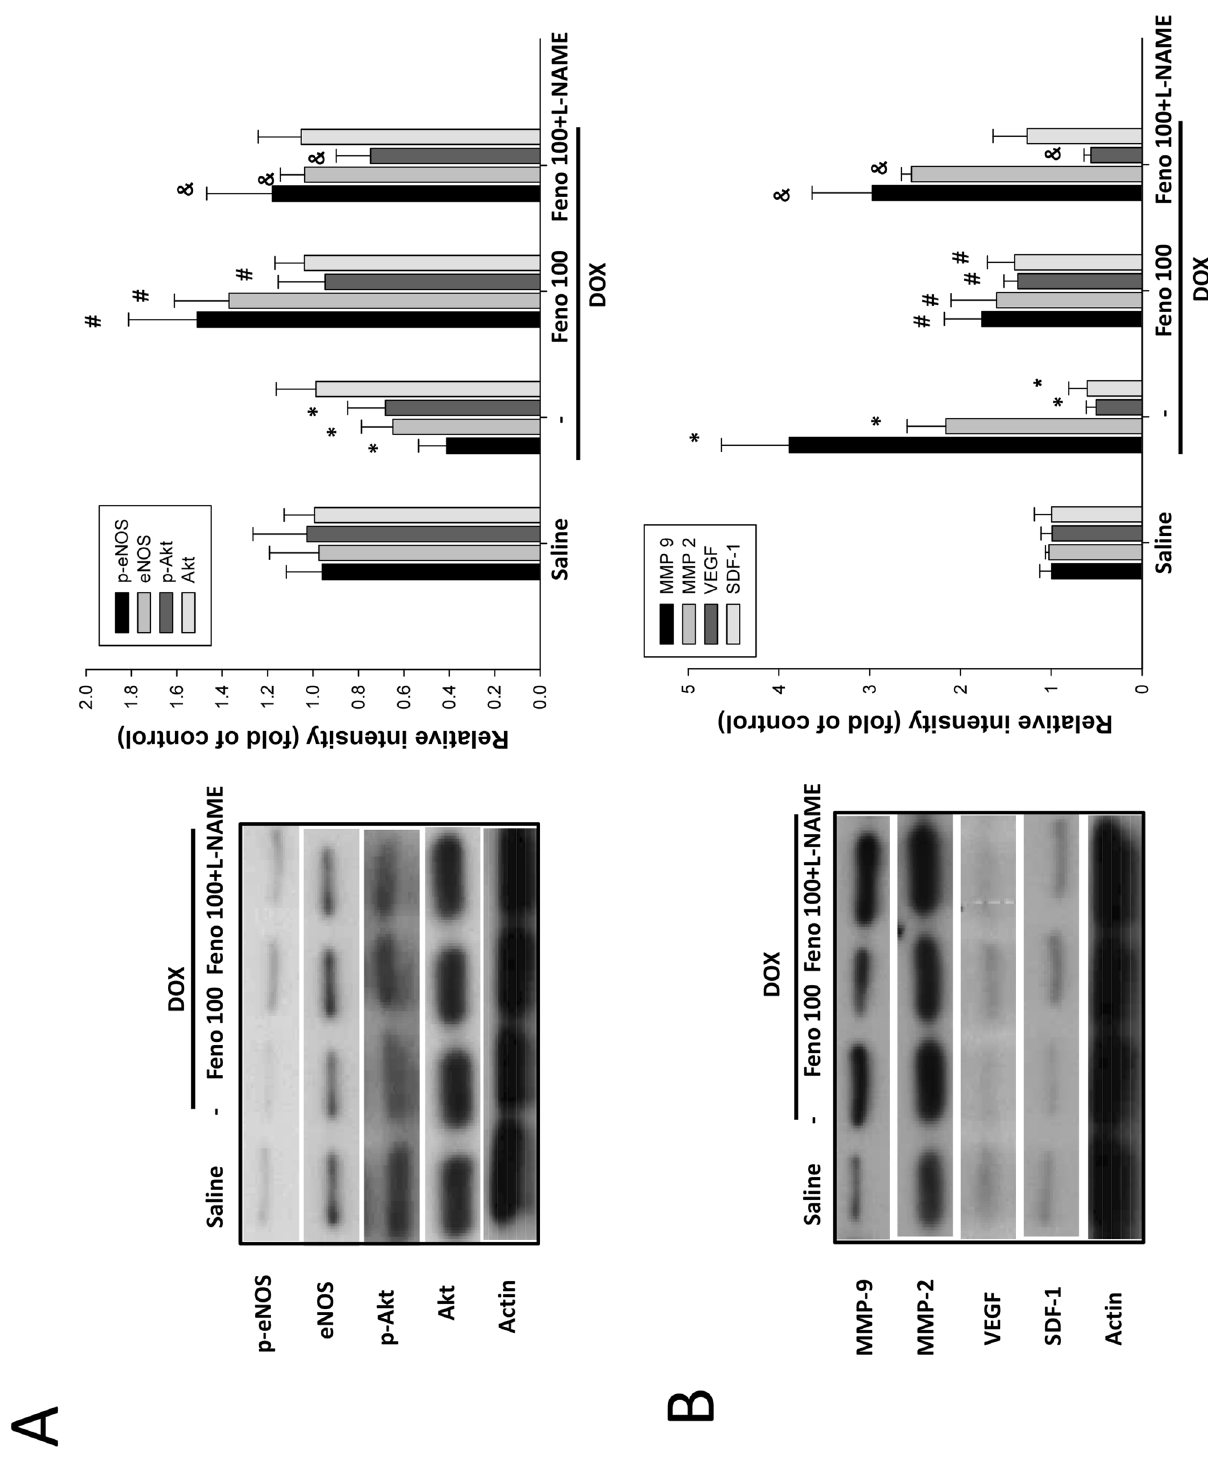
Figure 4. Effect of fenofibrate on endothelial activation marker expression in the hearts of FBV mice after DOX treatment. ( A ) Protein expression of endothelial activation signaling pathways. The phosphorylation of Akt/eNOS was measured by Western blot and normalized to the phosphorylation of the control group. ( B ) The protein expression levels of the inflammation and angiogenesis proteins MMP-9, MMP-2, VEGF, and SDF-1 were tested and normalized to the expression levels in the control group (mean ± SDs, n = 3). * p < 0.05 versus saline; # p < 0.05 versus DOX alone; and p < 0.05 versus DOX + fenofibrate. One-way